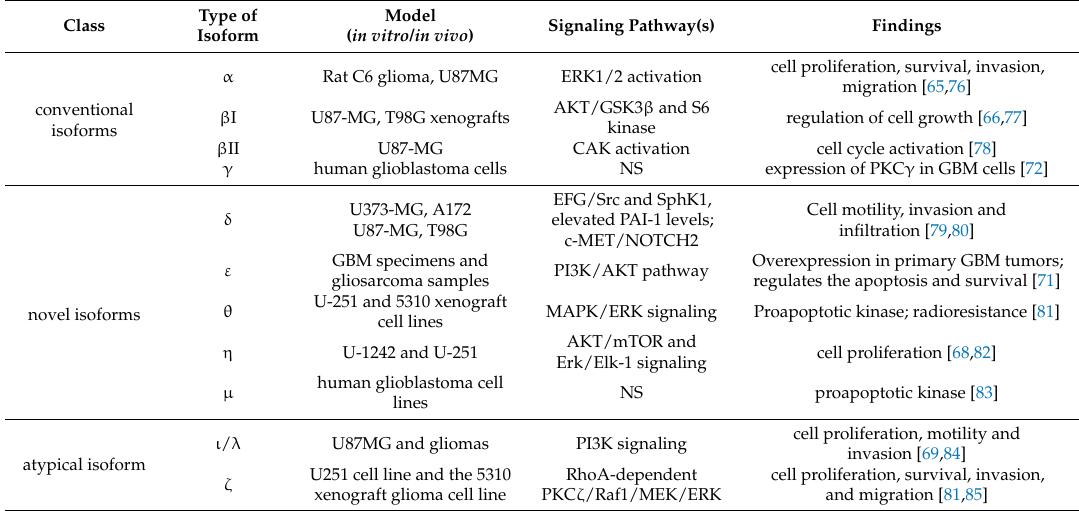
Abbreviations used in the table are defined as follows: GSK3 β , Glycogen synthase kinase 3 β ; S6K, ribosomal S6 protein kinase; c-MET, tyrosine-protein kinase Met (mesenchymal epithelial transition); NS, not studied;